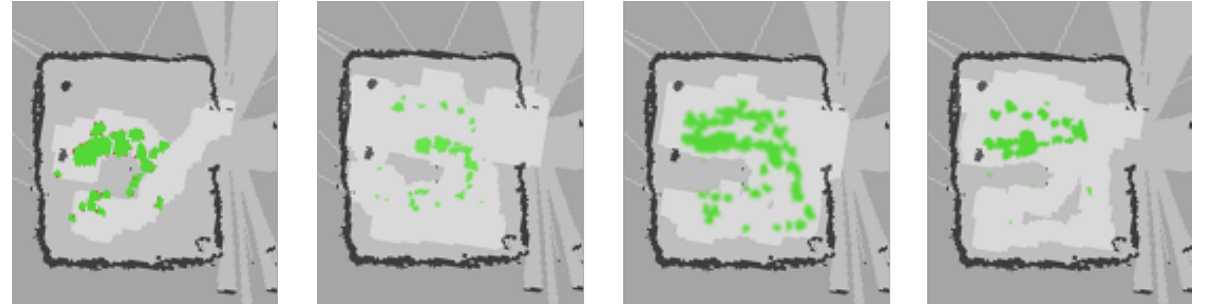
Figure 3. Directly detected footprints (green) overlaid with modeled areas of contamination (light